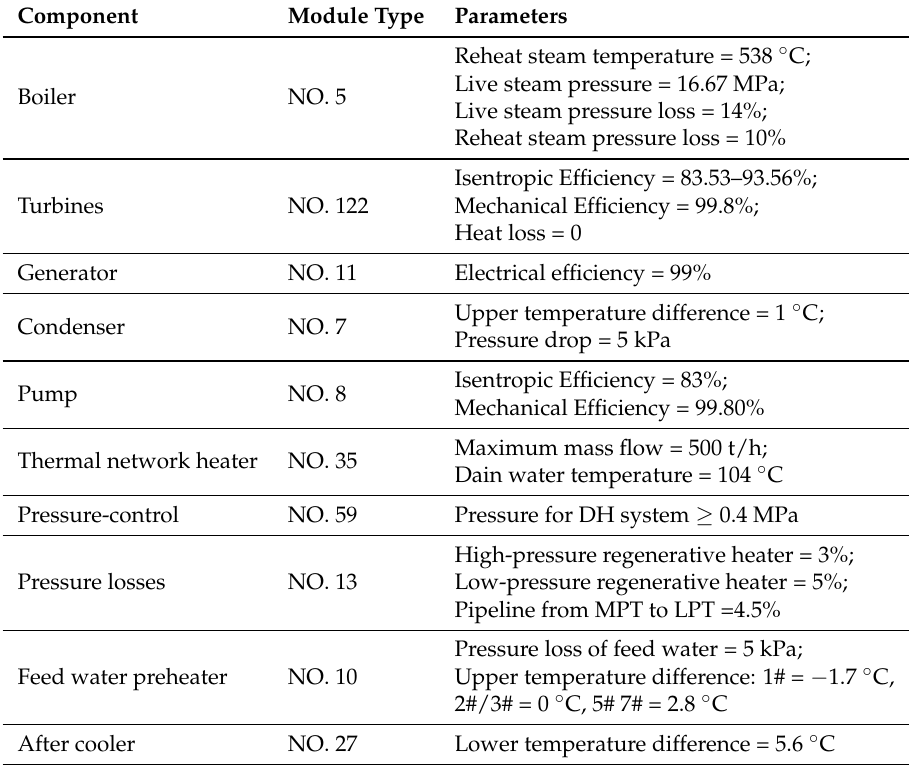
Table 4. Model details of the main components in EBSILON